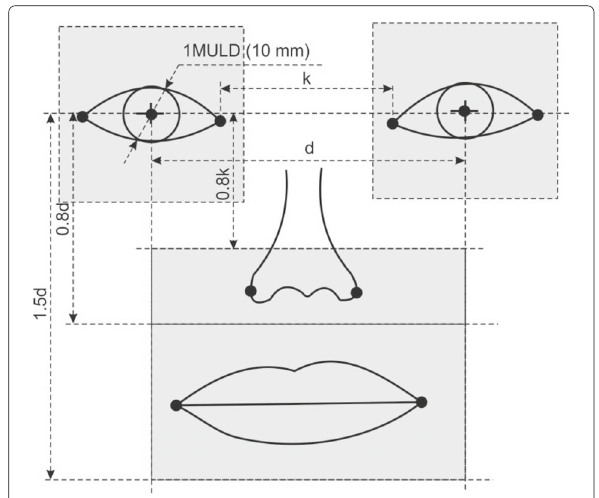
Fig. 1 The scheme of searching face areas in order to find the characteristic points